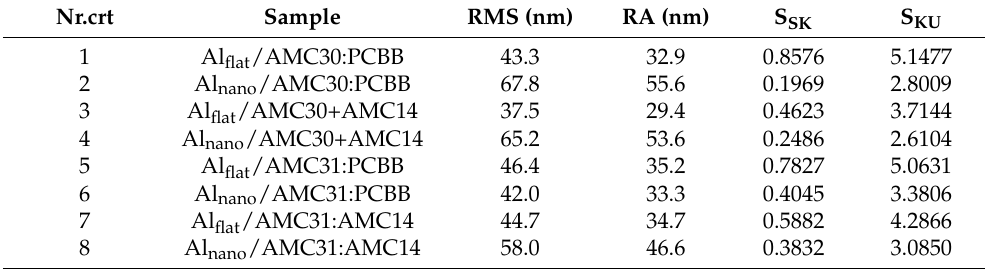
Table 1. AFM roughness parameters of the mixed layers deposited on Al flat and Al nano : RMS, RA, S SK and S KU .